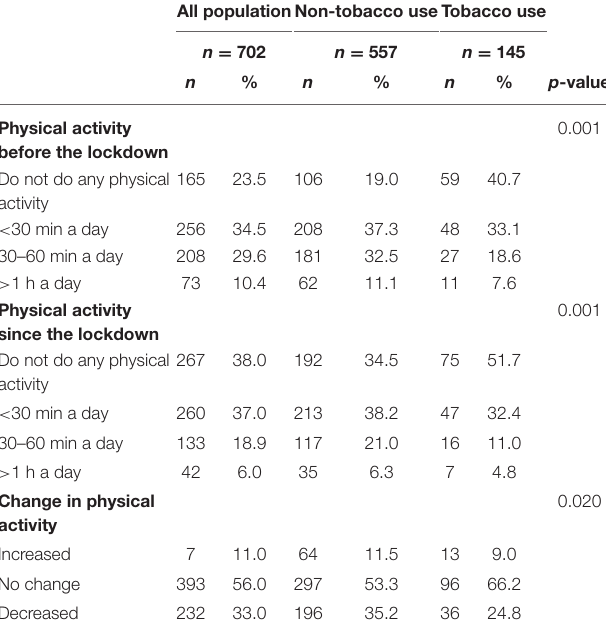
TABLE 4 | Impact of the lockdown on physical